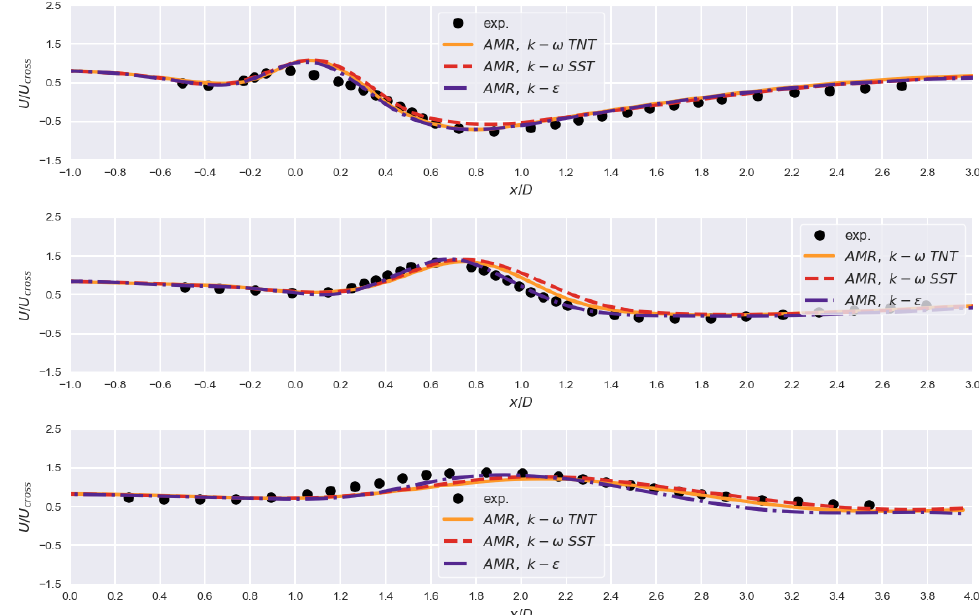
Figure 8. Velocity component U / U cross when using AMR at z / D = 1.5, z / D = 3, z / D = 4.5 (top to bottom) for y / D =